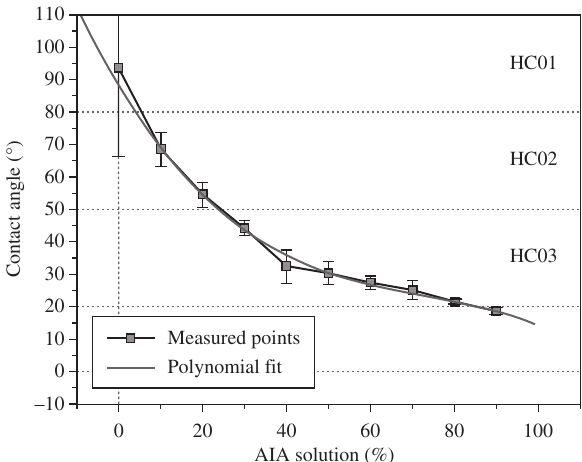
Figure 2. %AIA solution vs. contact angle.